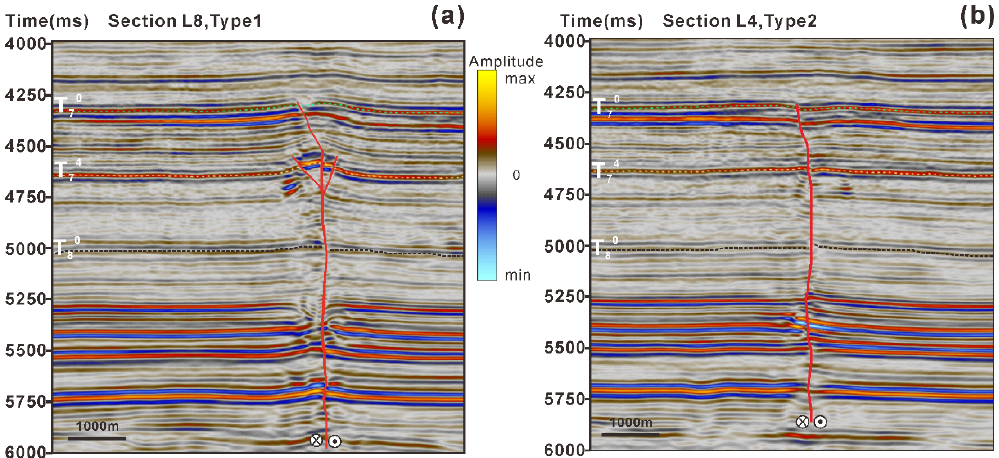
Figure 5. Typical seismic profile across the Shunbei 5 fault zone. ( a , b ) are two structural styles, respectively.